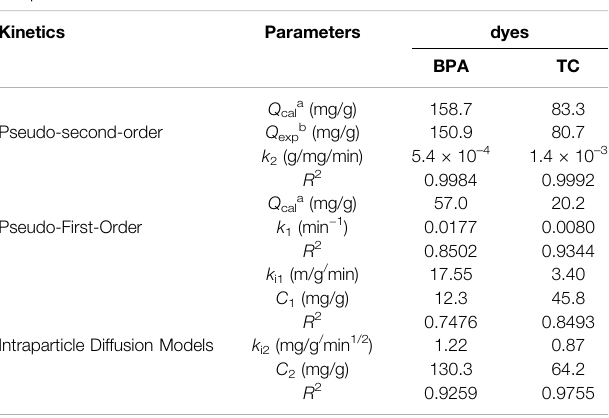
TABLE 3 | Isotherm parameters of Fe 3 O 4 @MIL-53(Al)-NH 2 for BPA and TC